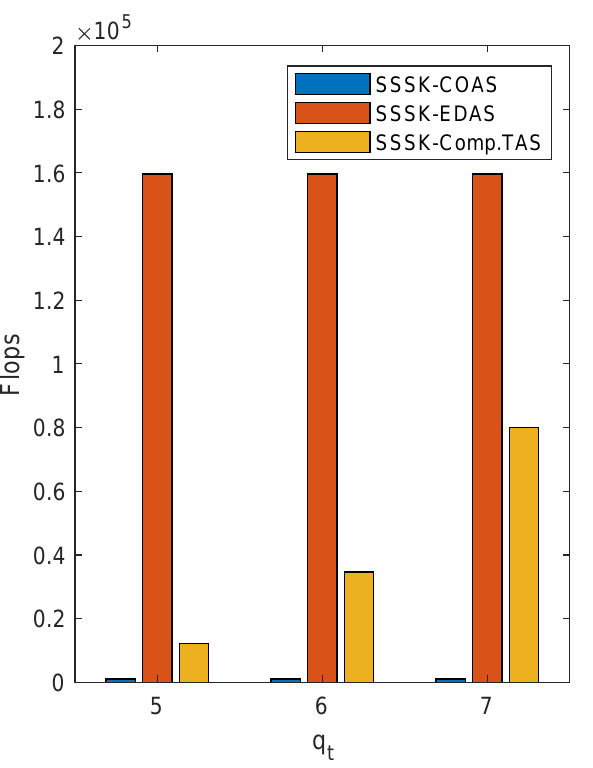
Figure 6. Complexity of SSSK with multiple TAS algorithms with N t = 8, q = 4, N r = 1 and L = 2